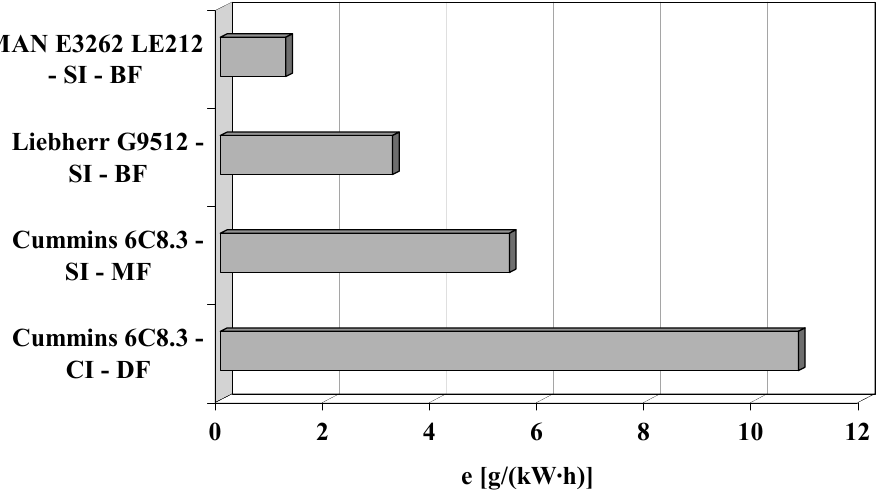
Figure 11. Specific brake emission of nitrogen oxides in the D2 test for the studied engines running on diesel fuel (DF), methane fuel—natural gas (MF) and biogas (BF). Significantly, the specific emission of carbon monoxide and hydrocarbons for the Cummins 6C8.3 engine in both versions (fueled with the diesel and natural gas as a sub- stitute for biomethane) is relatively low (above 0.4 g/(kW · h) of carbon monoxide and above 0.2 g/(kW · h) of hydrocarbons for SI engine and respectively above 0.5 g/(kW · h) of carbon monoxide and above 0.6 g/(kW · h) of hydrocarbons for CI engine), while the specific emission of nitrogen oxides is significantly higher than for typical engines for CHP aggregates supplied with the biogas. This is due to the fact that the Cummins 6C8.3 engine was originally intended for the drive of motor vehicles, and in the modified configuration, for the drive of working machines. These are the engine operating conditions, characterized by a relatively low relative load (in relation to the maximum engine load), which is particu- larly visible for the average relative power use in the research tests for ECE R 49.02 and ESC, as well as NRSC in relation to the D2 test. In addition, the algorithms for controlling the work processes of Liebherr G9512 and MAN E3262 LE212 engines are adapted only to work in the driving conditions of power generators with the priority of reducing the specific emission of nitrogen oxides, because it is one of the most important problems